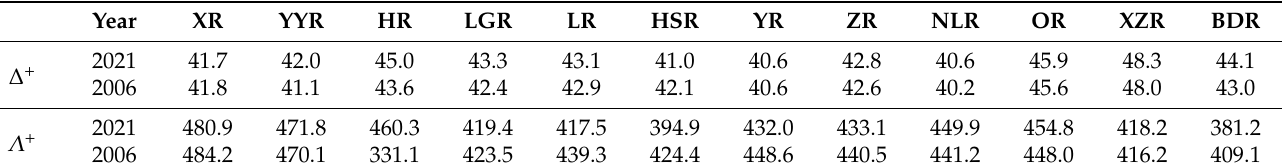
Table 2. The average taxonomic distinctness ( ∆ + ) and variation in taxonomic distinctness ( Λ + ) of 12 Sub − basins in Guangxi. Sub − basin codes are described in Table 1.